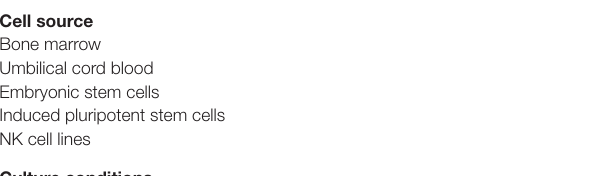
TABLe 1 | Factors affecting the ouctome of the manufacturing process of nK cell-based medicinal